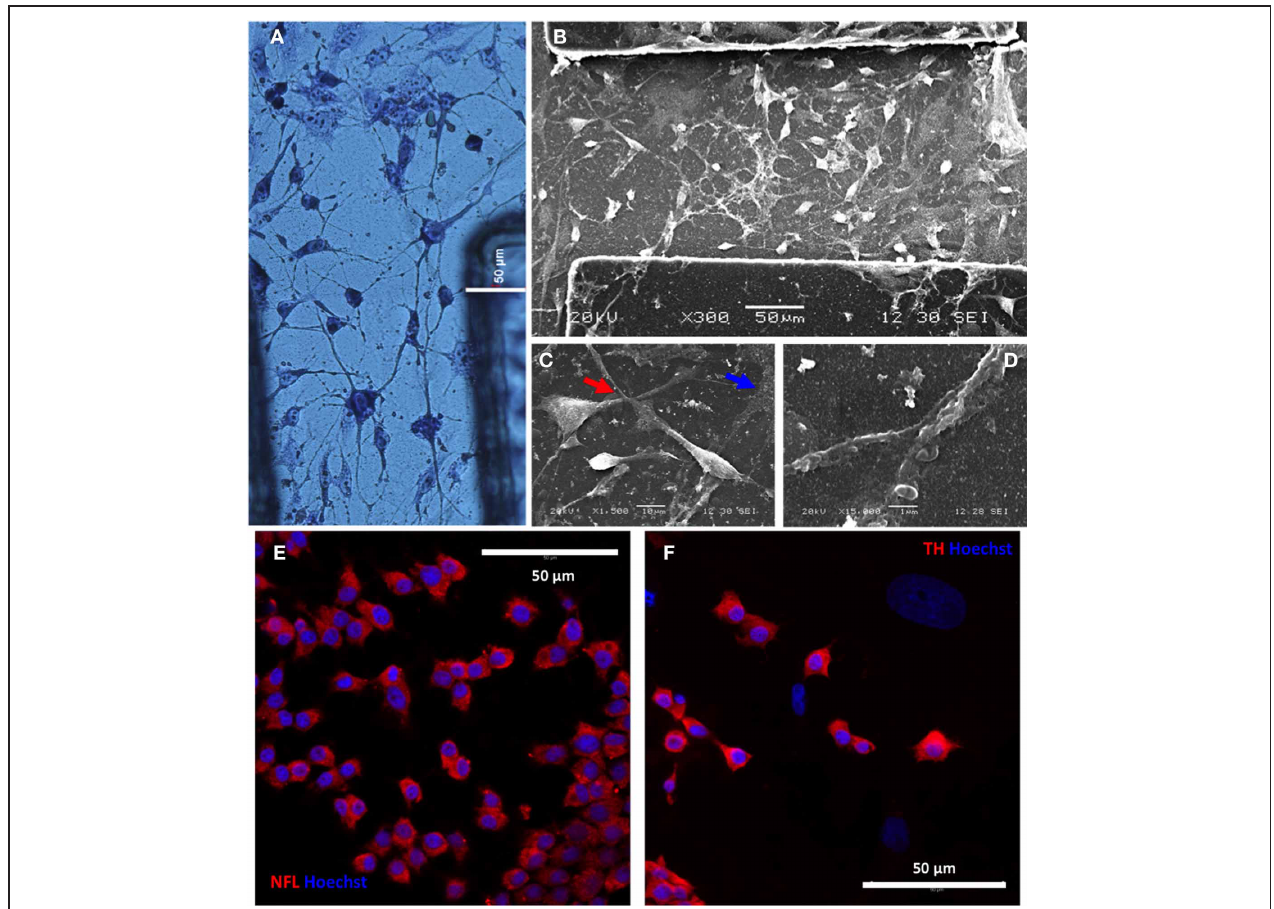
traces of neural extracellular matrix in the preparation ( C , blue arrow) after 14 days in vitro . A putative dopaminergic neuronal phenotype was shown by intracellular expression of neurofilament L (NFL; panel E ) and tyroxine hydroxilase (TH; panel F ) markers, as seen by inmmunofluorescence and confocal microscopy (red). Cell nuclei were counterstained with Hoechst 33258